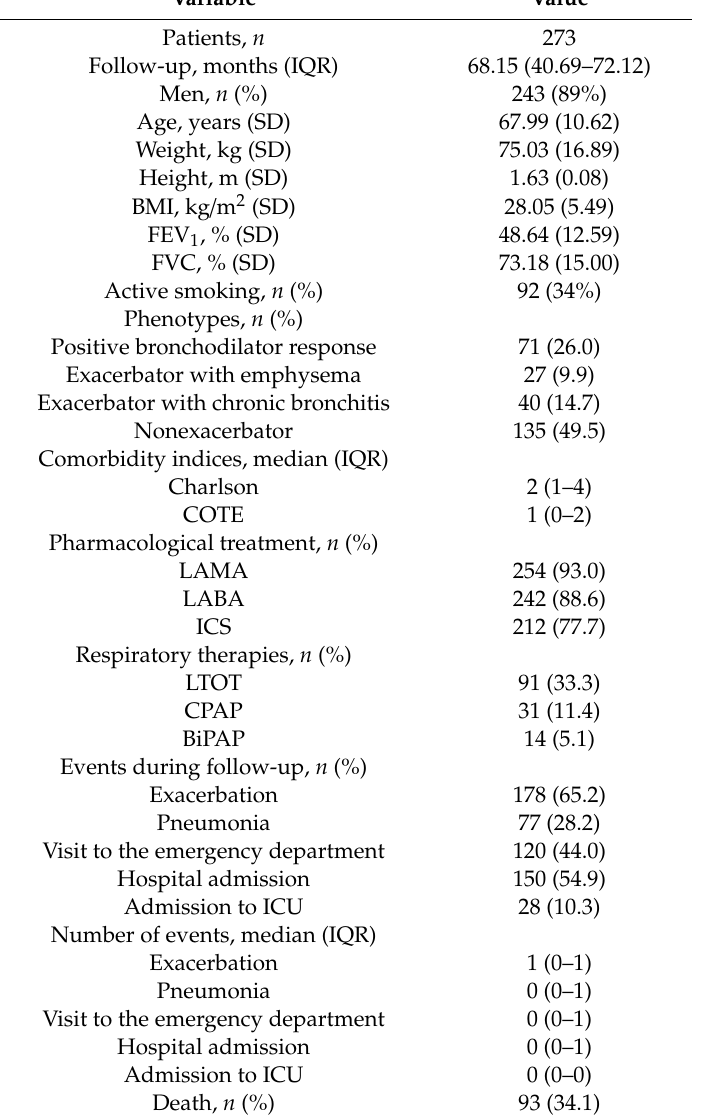
Table 1. General characteristics of the patients included in the